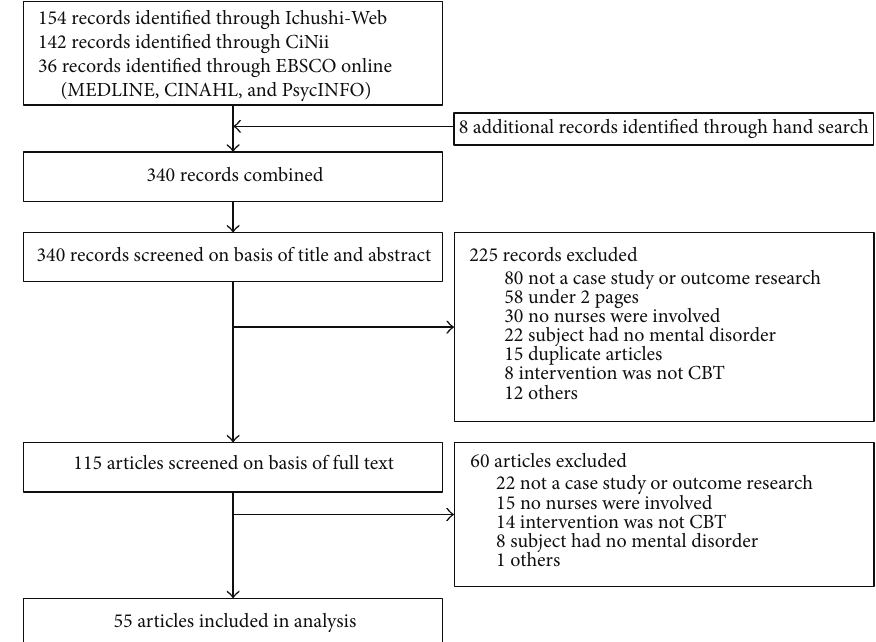
Figure 1: Literature selection